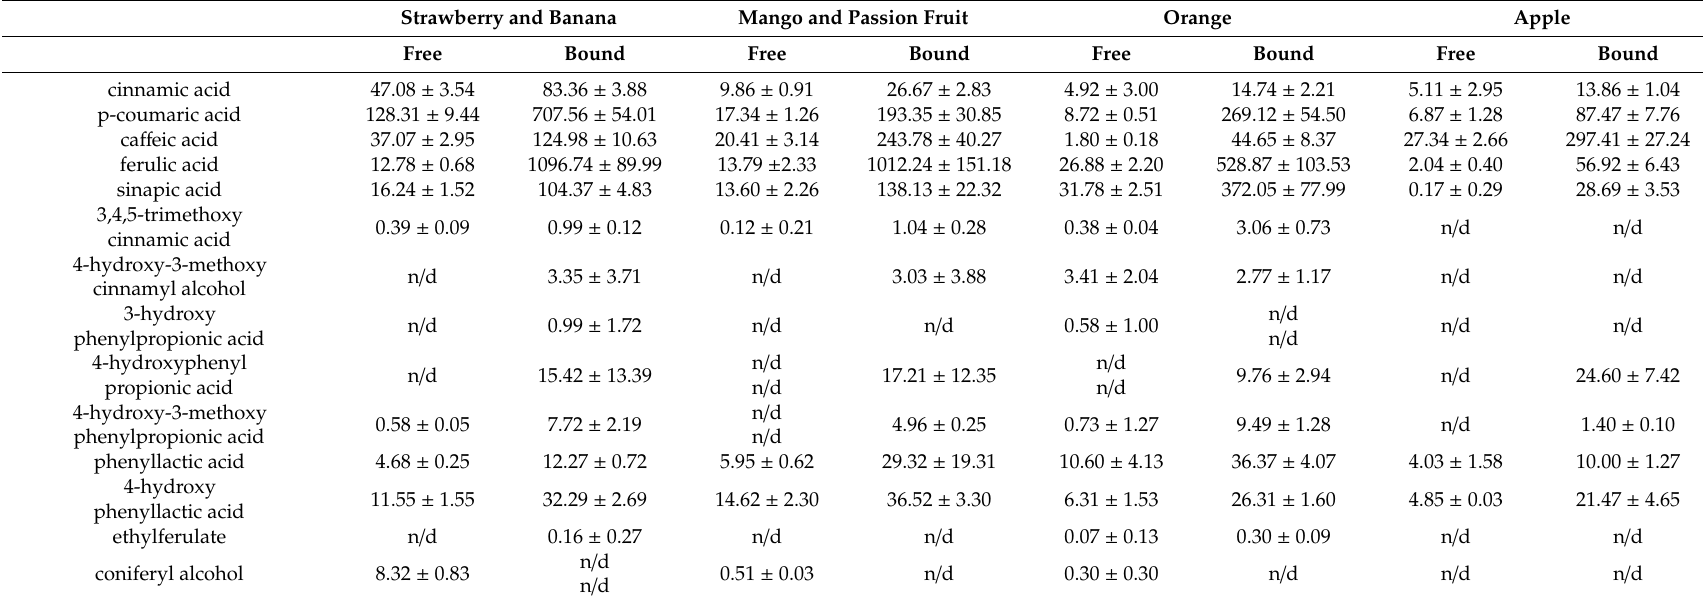
Table 2. Cinnamic acid derivative content of juice / smoothie